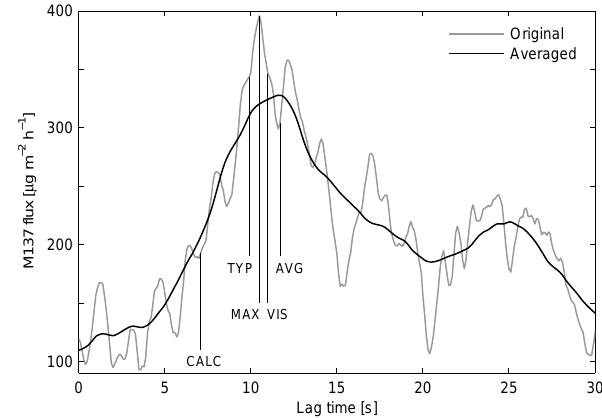
Fig. 2. Covariance function of H 2 O calculated in the EC and DEC manner (9 August 2007 12:00–12:45). The comparison illustrates how DEC increases the noise and thus the flux uncertainty. The shaded areas show the lag time ranges used in the uncertainty esti- mation, which was based on the standard deviations of the covari- ance function. Note that only the EC fluxes of H 2 O were used as a reference in the DEC simulation (Sect. 2.2). The DEC version of the covariance function of H 2 O is a mere illustration.